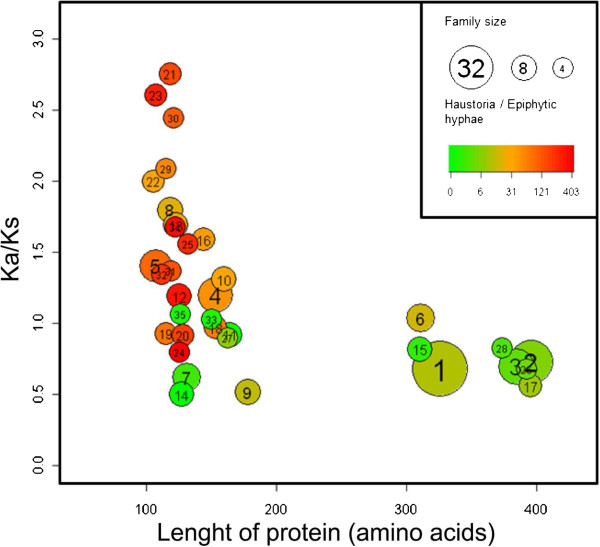
The relationship between the length of CSEPs, the degree of positive selection and the ratio of expression in haustoria compared to expression in epiphytic hyphae. Ratio of the non-synonymous to synonymous substitutions (Ka/Ks) within CSEP families is plotted against the length of the proteins. The values of the parameters for the axes were calculated as family averages; the family numbers are indicated in the circles. The ratios of CSEP expression in haustoria and epiphytic hyphae are as indicated in the colour bar. The diameter of the circles indicates the relative size of the families.